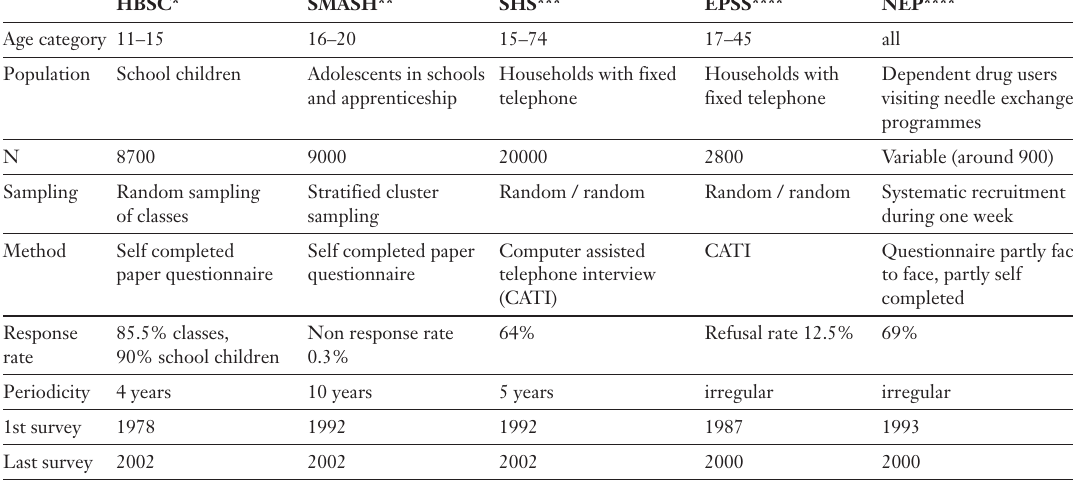
Main characteristics of periodic surveys used in this